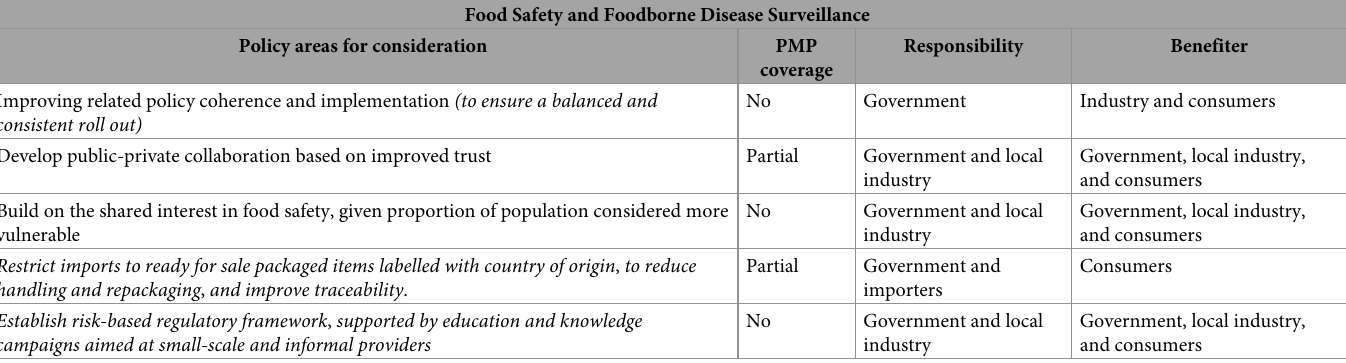
Table 4. Summary of food Safety and foodborne disease surveillance policy areas for consideration. Original ideas presented in meetings are in plain font, and stake- holder additions in italics (PMP = Poultry Master